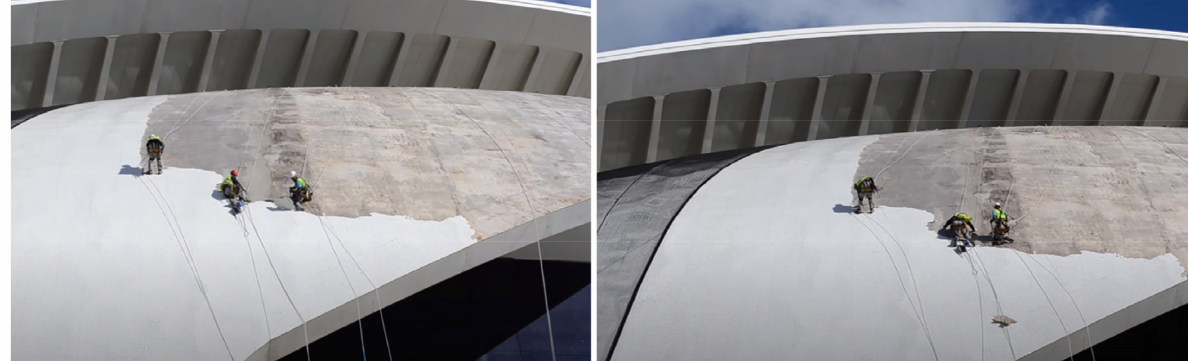
Figure 5. Palau de les Arts Reina Sofia, Valencia (2005). The removal of the trencad í s, images from video. Reprinted with permission from Tono Mañes. Copyright 2005 Tono